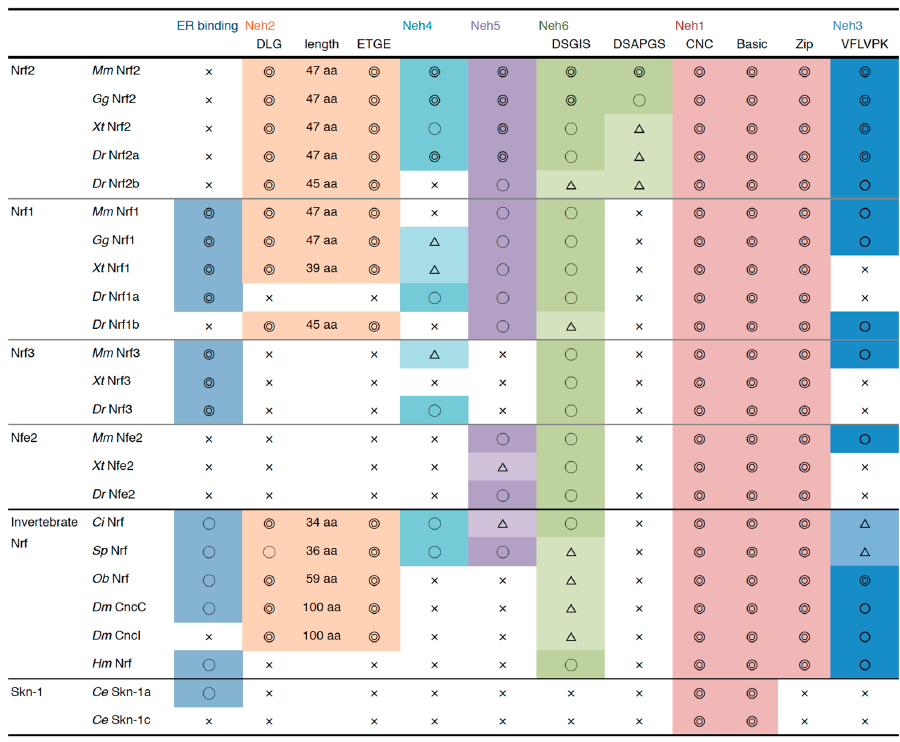
Figure 3. A summary of the domain structure of the Nrf/Cnc transcription factors. Conservation of the Neh domains was evaluated as follows: ◎ , highly conserved; ○ , relatively conserved; △ , partially conserved; ×, not conserved. Specific motifs were described as “highly conserved” only when the sequences were identical to mouse Nrf2. The amino acid lengths between DLG and ETGE motifs are also shown.